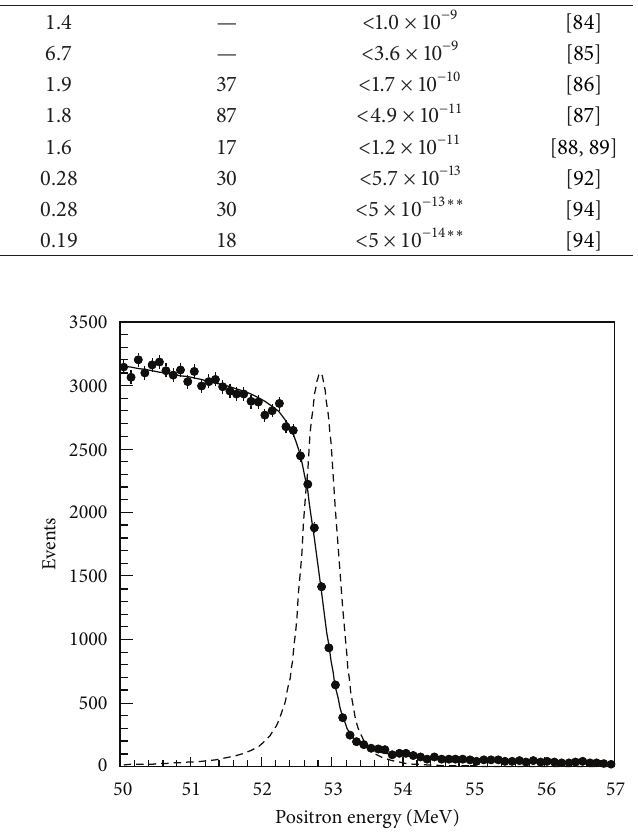
Figure 13: Spectrum of Michel decay positrons measured by the MEGA experiment. The continuous line is the global fit of the spectrum and the dashed line is the positron response function extracted from the fit and used in the likelihood analysis [88].